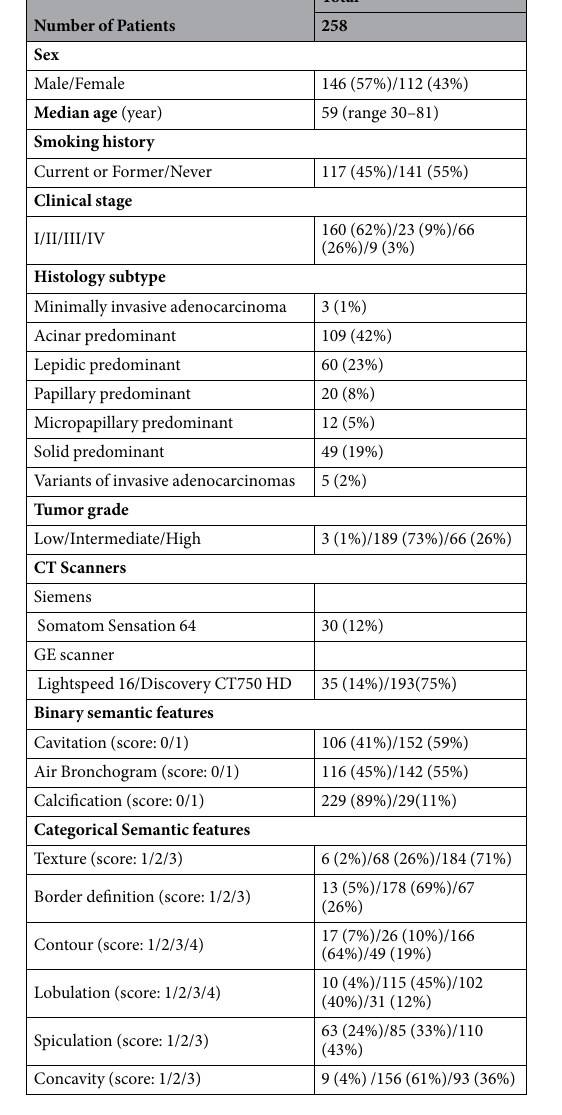
Table 1. Patient characteristics. Distribution of patient tumor characteristics and radiologists’ scoring for semantic